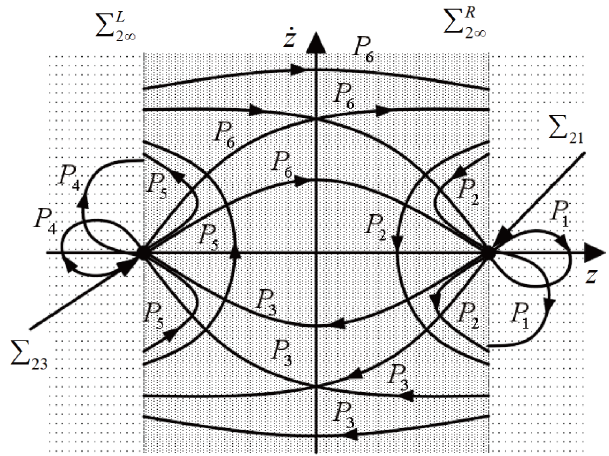
Figure 4. The mapping structures.